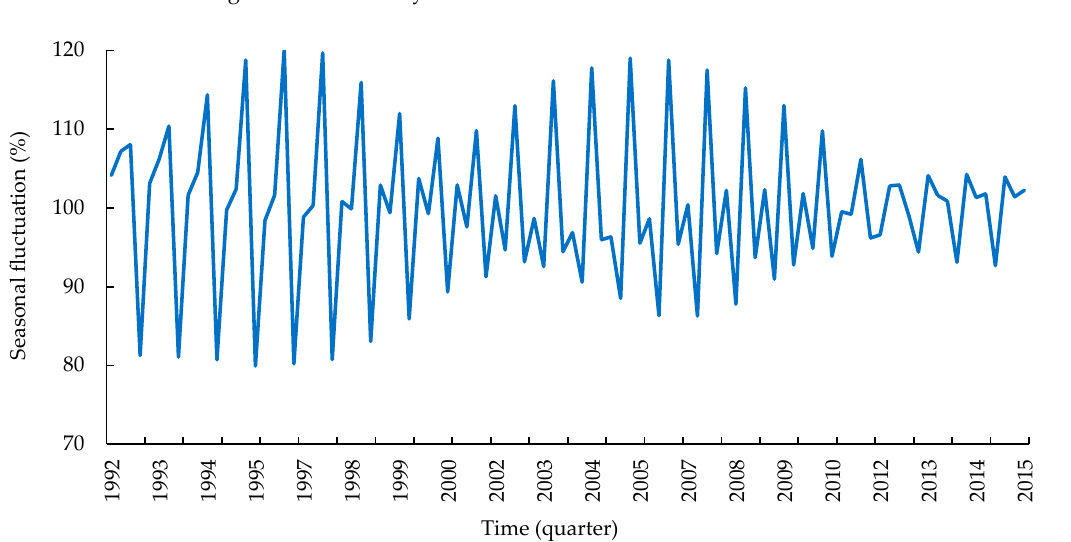
Figure 9. Decomposition of the time series of construction activities, including irregular fluctuation indices in Hyrcanian forest in 1992–2015. 3.6. Similarity of Seasonal Index Patterns As shown in Figure 10, Q2lum and Q3sawlog have the same pattern as Q3R. There- fore, the seasonal indices of the sawlog and lumber prices have the same pattern as the seasonal fluctuation of construction activities.